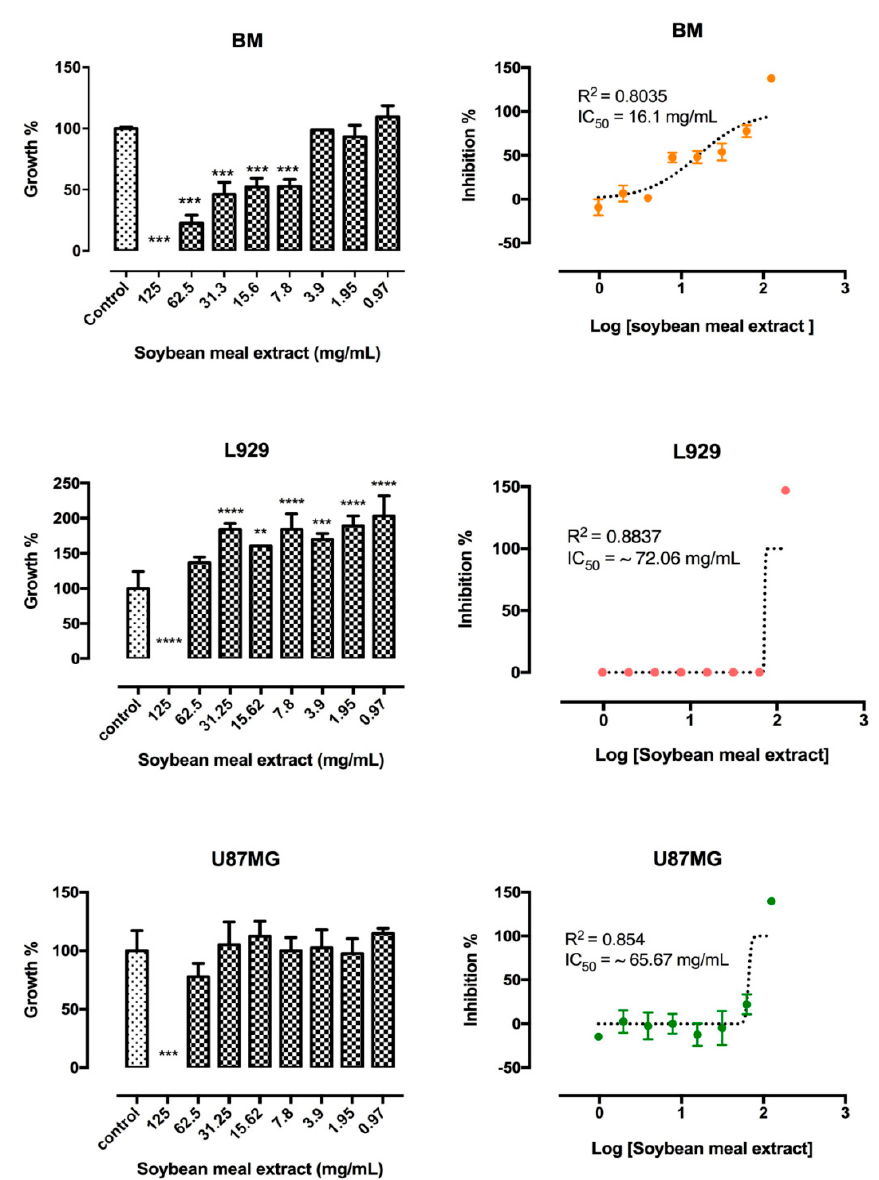
Figure 2. Cytotoxicity of soybean meal aqueous extract on mouse bone marrow (BM) cells and fibroblast L929 cell lines and on the human glioblastoma U-87 MG cell line. Growth versus soybean meal aqueous extract concentration plot (left-hand panel) after 24 h exposure. Right-hand panel shows the inhibition versus Log of soybean meal aqueous extract concentration after 24 h exposure. Results were expressed as the mean ± standard deviation ( n = 3). Differences between the untreated cells (control) and those incubated with concentrations from 125 mg/mL to 0.97 mg/mL of soybean meal aqueous extract were evaluated by the One-way ANOVA test, with the Tukey post-test where ** p < 0.01; *** p < 0.001; **** p < 0.0001.